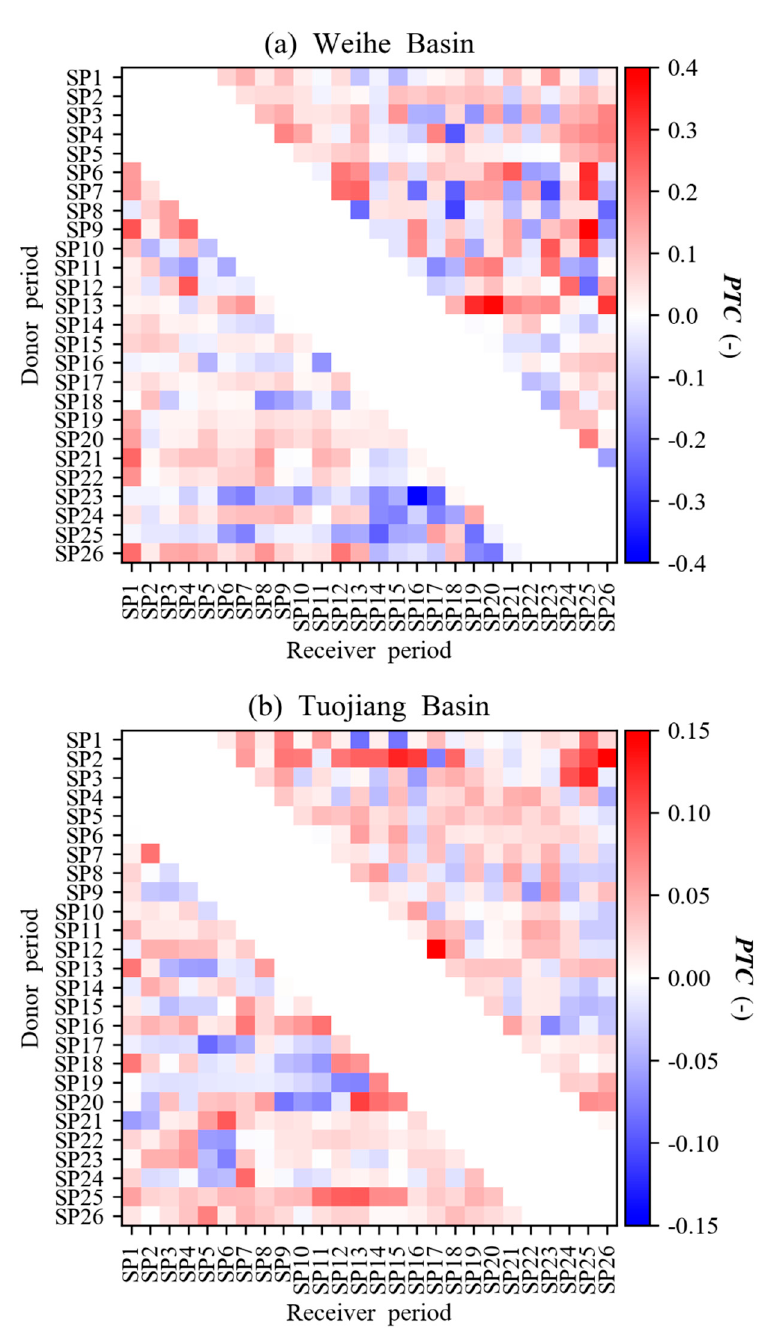
Figure 10. PTC values of the parameter transferability test for ( a ) Weihe Basin and ( b ) Tuojiang Basin.